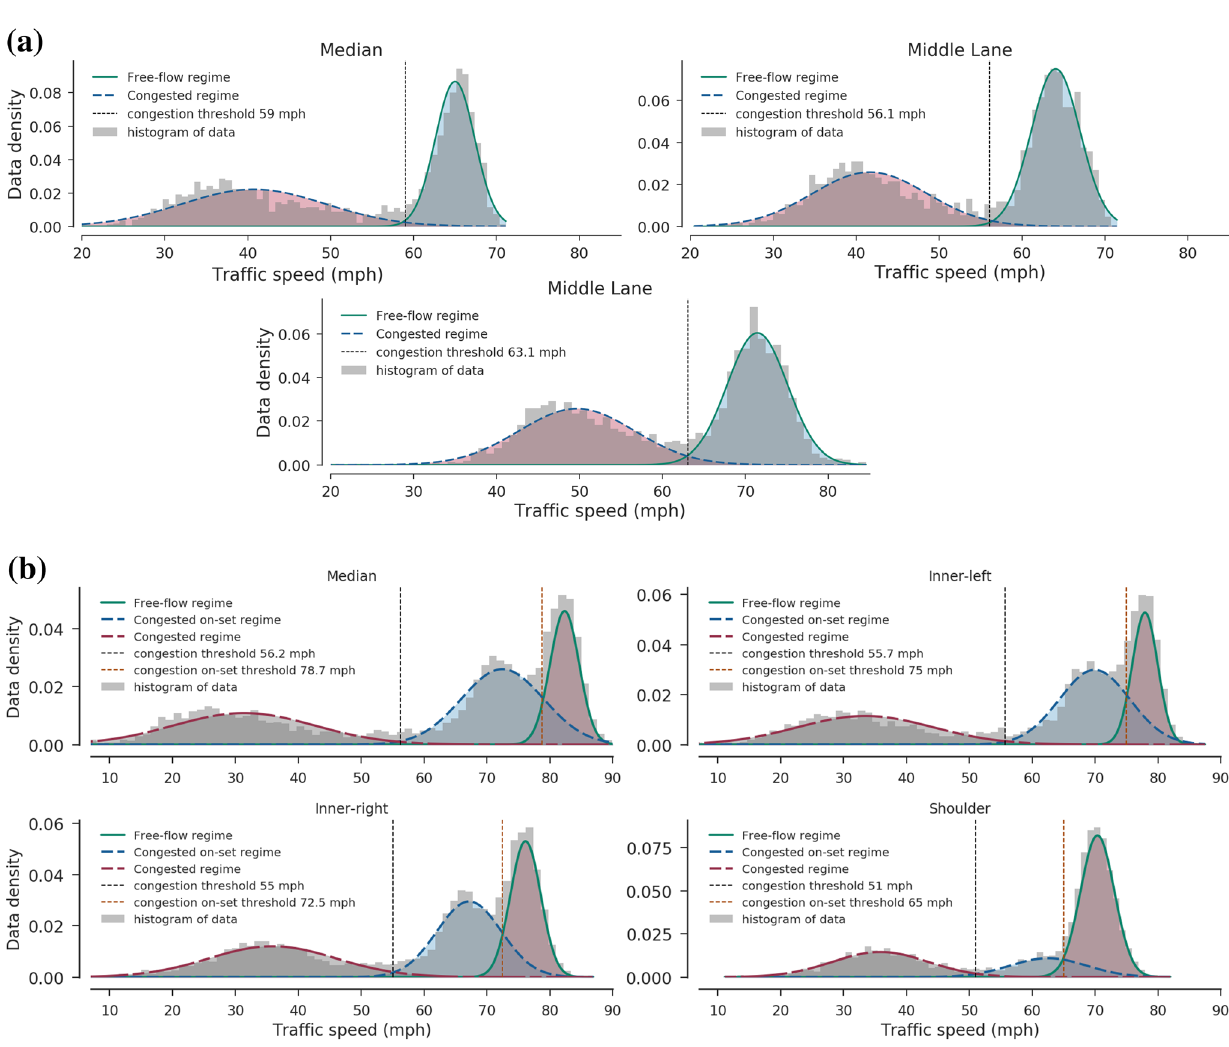
Fig. 2 Speed thresholds for clustering traffic regimes. a Site 1 dataset. b Site 2